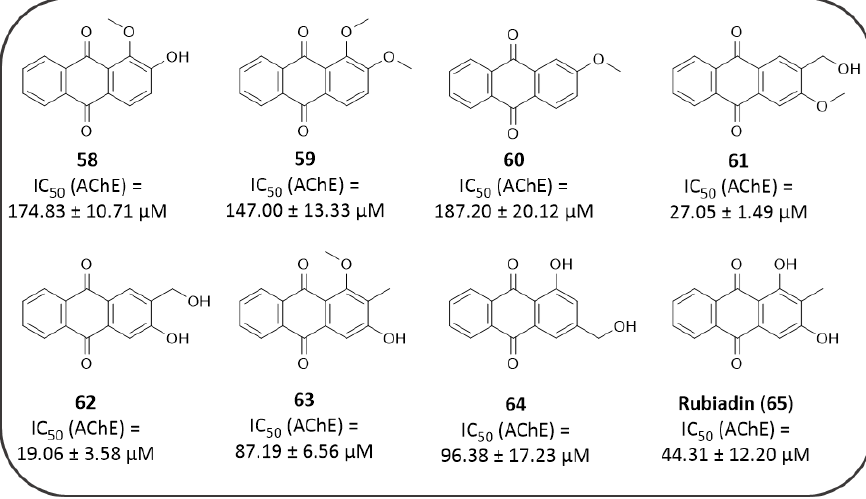
Figure 13. Other examples of AQs, devoid of 1,8-dihydroxy signature.